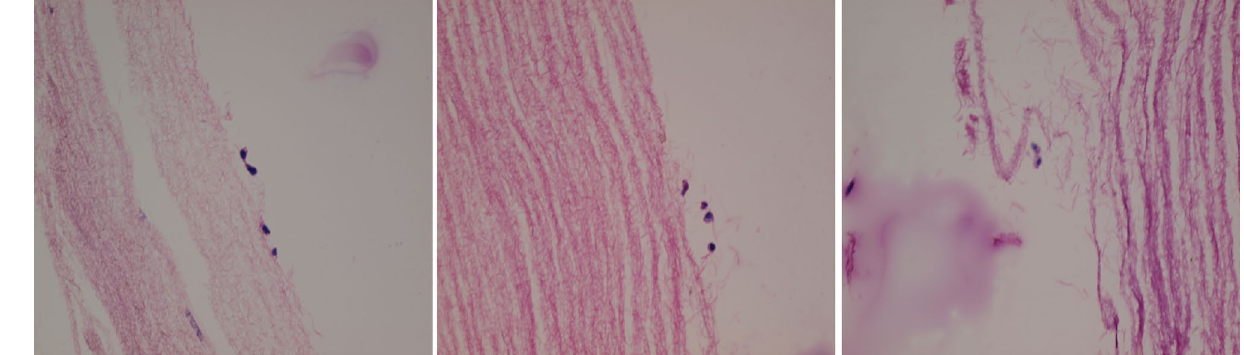
Figure 8. A device from 3rd day selected for (H&E) staining. Cells, nanofibrous mat (corrugated structure in pictures), and collagen hydrogel (soft structure) is